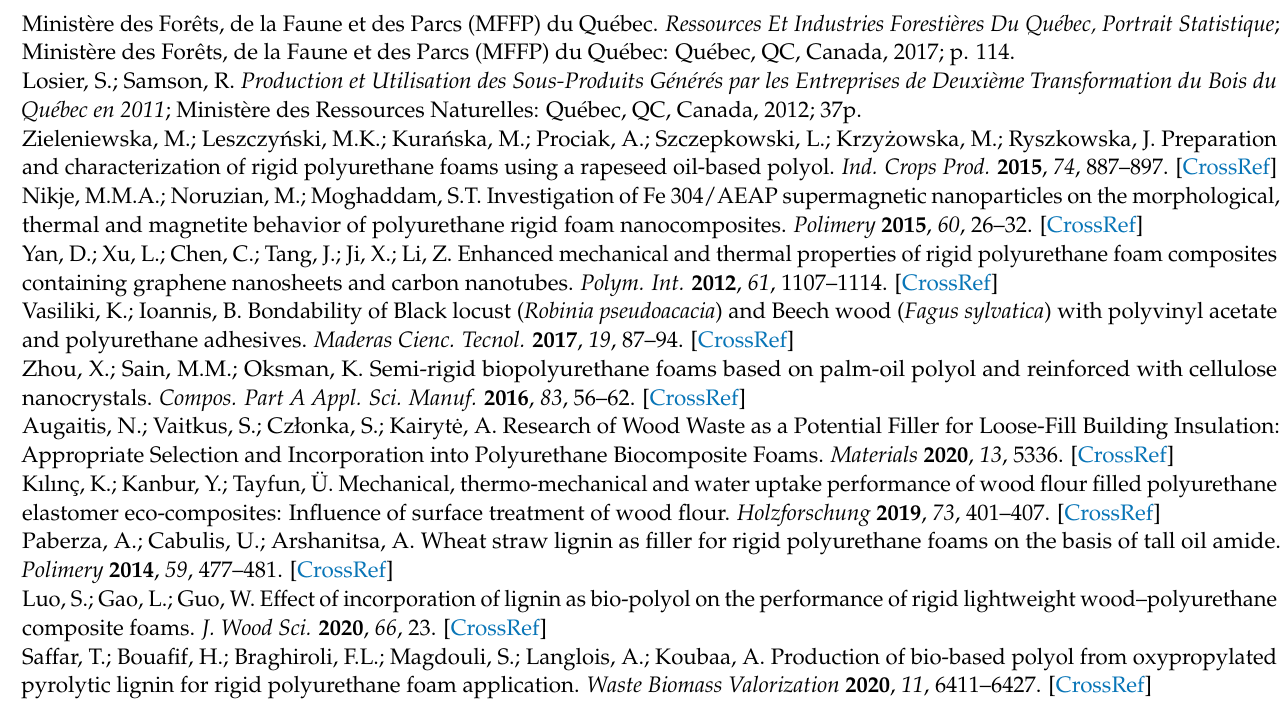
Table S1. Effect of particle size and percentage on compressive